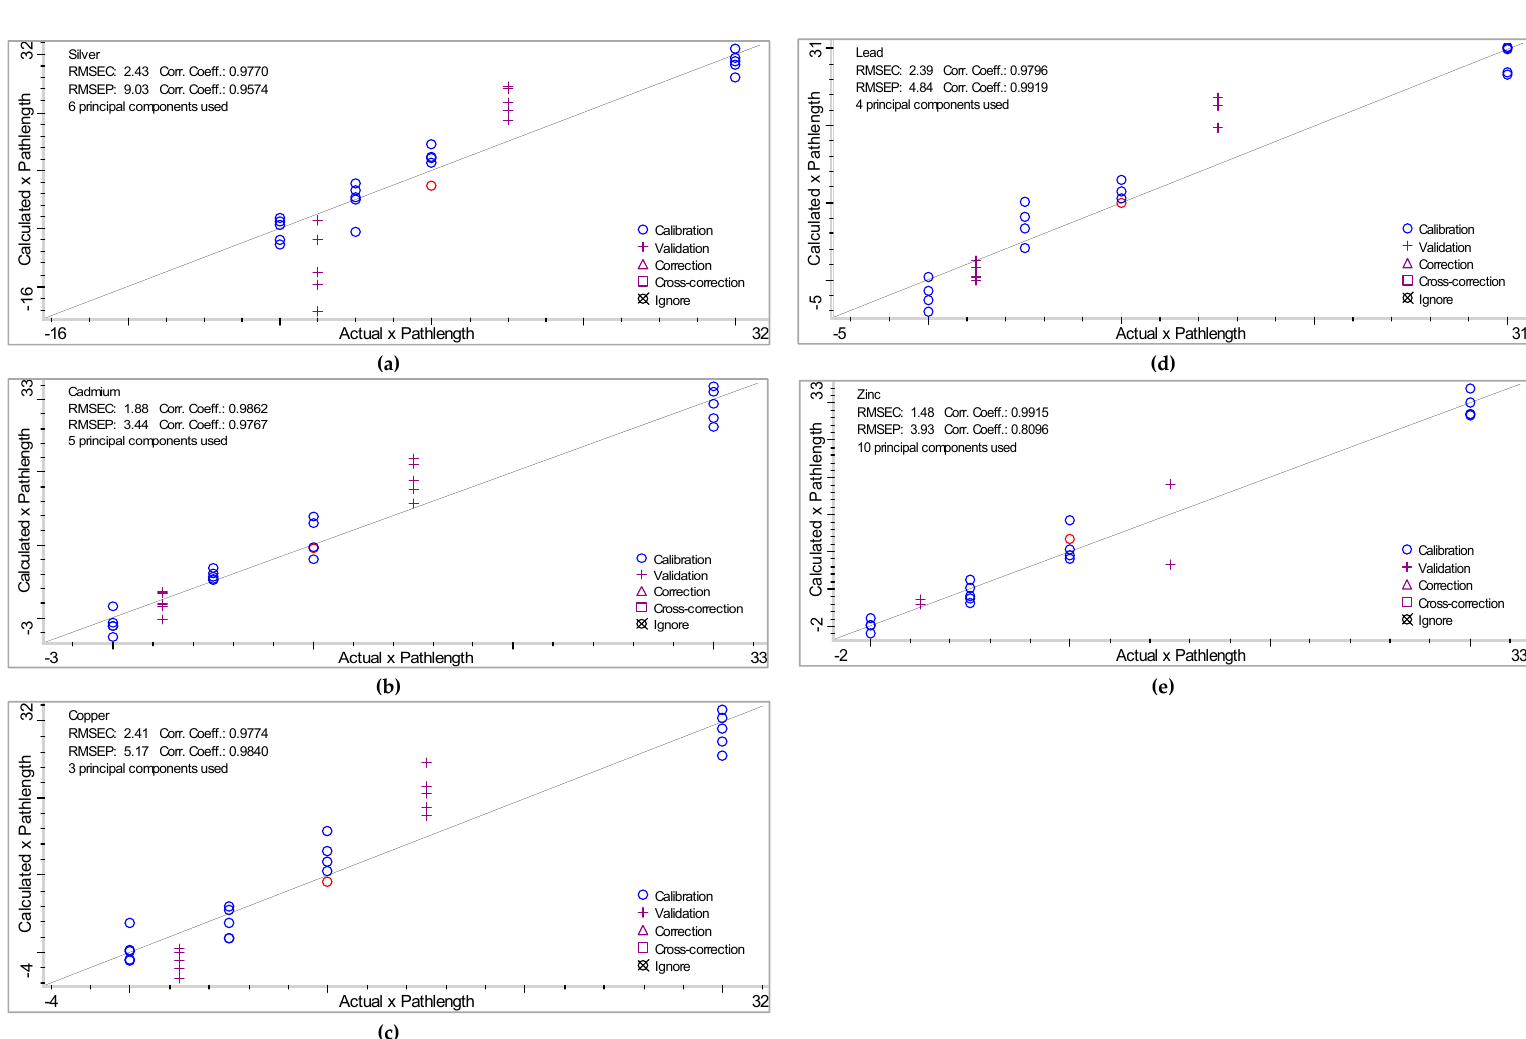
Figure 2. Showing the PCA calibration models for caption ( a ) Ag; ( b ) Cd; ( c ) Cu; ( d ) Pb; and ( e ) Zn.